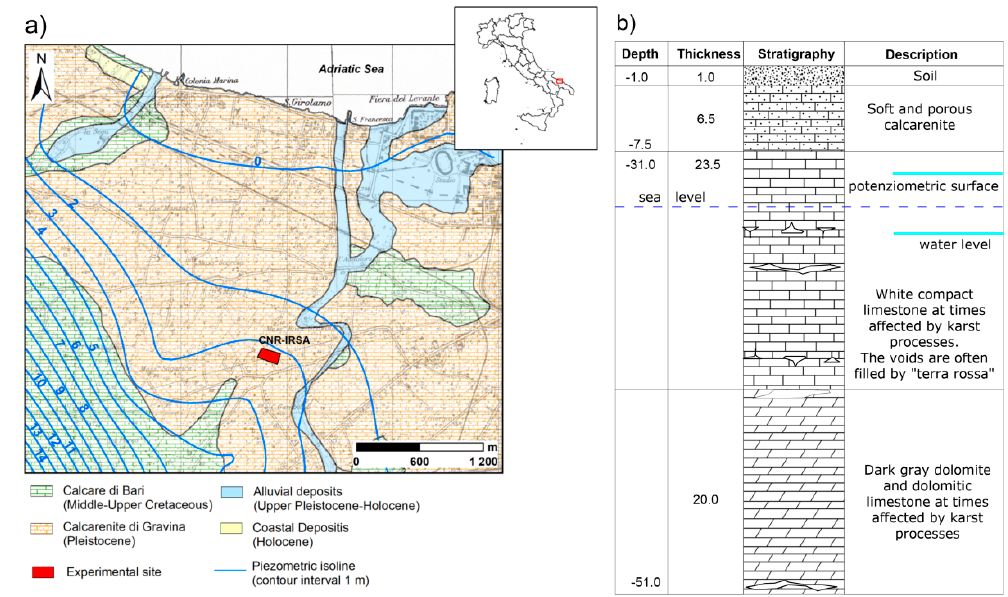
Figure 1. ( a ) Geological sketch of the investigated area; ( b ) stratigraphic column.